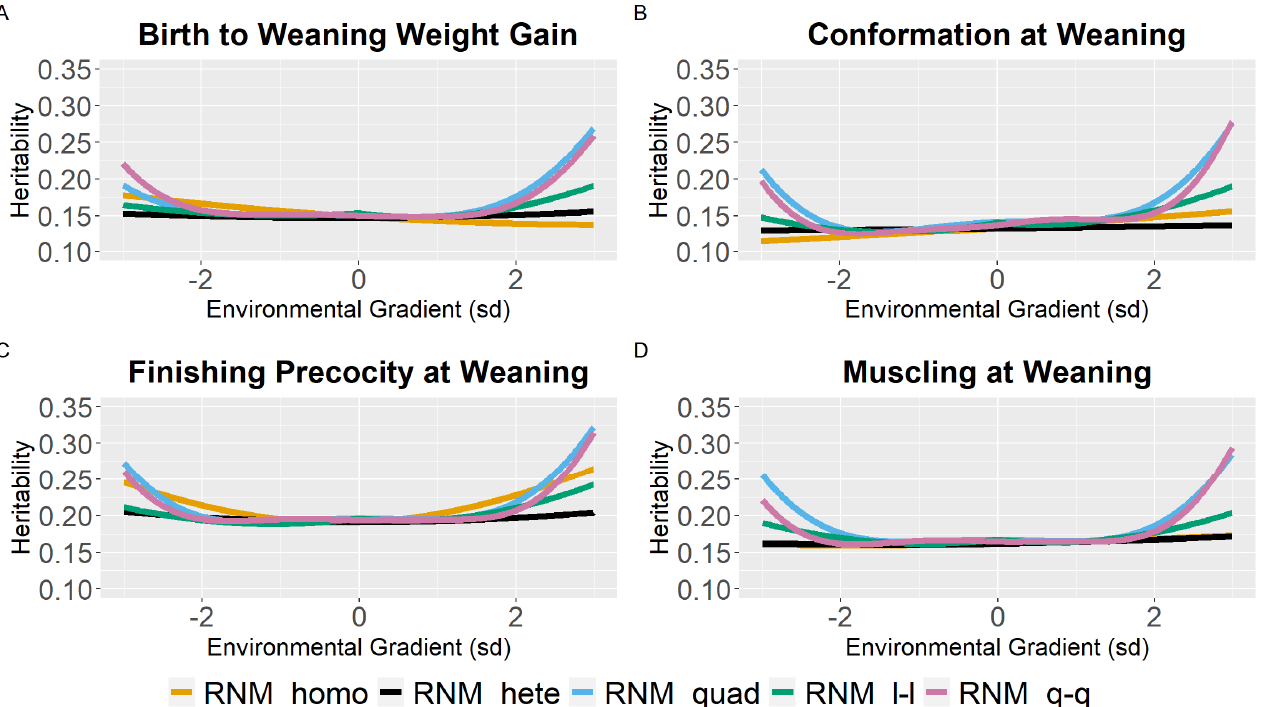
Figure 1. Heritability estimates (h 2 ) for birth to weaning weight gain ( A ), conformation ( B ), finishing precocity ( C ), and muscling ( D ) at weaning traits in Nellore cattle according to the environmental gradient (standard deviation, sd), for different reaction norm models. RNM_homo: linear homoscedastic; RNM_hete: linear heteroscedastic; RNM_quad: quadratic heteroscedastic; RNM_l-l: spline linear–linear heteroscedastic; RNM_q-q: spline quadratic–quadratic heteroscedastic. For WYG, there are differences between models in the heritability estimates, mainly at the extreme gradients (Figure 2). For RNM_homo, the heritability estimates increased with the increase in EGs and tended to be underestimated in poor gradients and overestimated in better gradients when compared to models that assume heterogeneity of residual variance.